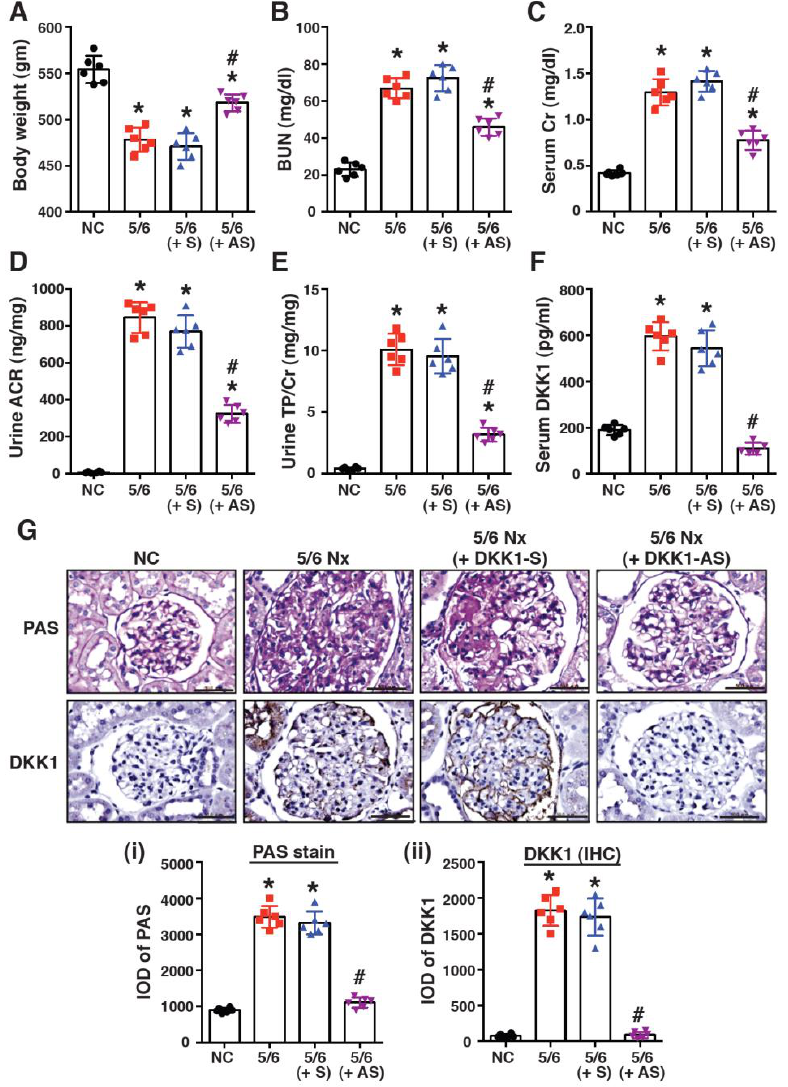
Figure 2. Treatment of 5/6-nephrectomized (5/6 Nx) rats with the DKK1-antisense (DKK1-AS) oli- gonucleotide alleviates CKD-associated phenotypes. Body weight ( A ), blood urea nitrogen (BUN) level ( B ), serum creatinine (Cr) level ( C ), urine albumin/creatinine ratio (ACR) ( D ), urine total pro- tein/creatinine ratio (TP/Cr) ( E ) and serum DKK1 level ( F ) were analyzed in the sham-operated rats (NC) and in the 5/6 Nx rats that were left untreated or treated with the DKK1-sense (DKK1-S) or DKK1-antisense (DKK1-AS) oligonucleotide. Data are expressed as mean SD (n = 6 for each group). * p < 0.01 versus the sham group, # p < 0.01 versus the untreated 5/6 Nx group. ( G ) Repre- sentative images of PAS staining and IHC staining for DKK1 in renal glomeruli of the indicated treated groups. Scale bars: 50 μ m. Intensities of PAS staining and IHC staining for DKK1 in kidney sections from different groups were determined by quantitative integrated optical density (IOD) analysis and plotted in panels ( i ) and ( ii ), respectively. Data are represented as mean SD (n = 6 for each group). * p < 0.05 versus the sham group, # p < 0.05 versus the untreated 5/6 Nx group. In addition, the mRNA expression levels of DKK1 and the specific profibrotic factors in the renal glomeruli isolated with laser capture microdissection (Figure 3A) were eval- uated using RT-qPCR. Compared to the sham group, the mRNA levels in DKK1, TGF- β 1 and fibronectin were noticeably elevated in the 5/6 Nx group (Figure 3B). However, the